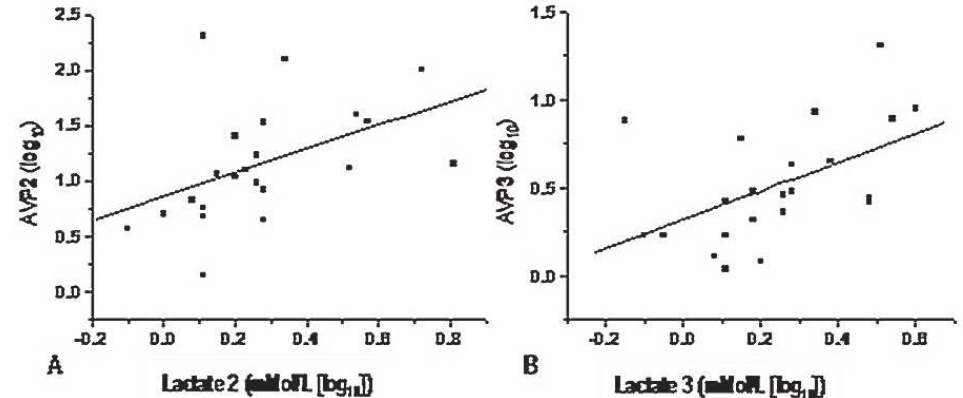
Fig. 2 – Correlations between plasmatic arginine-vasopressin and serum